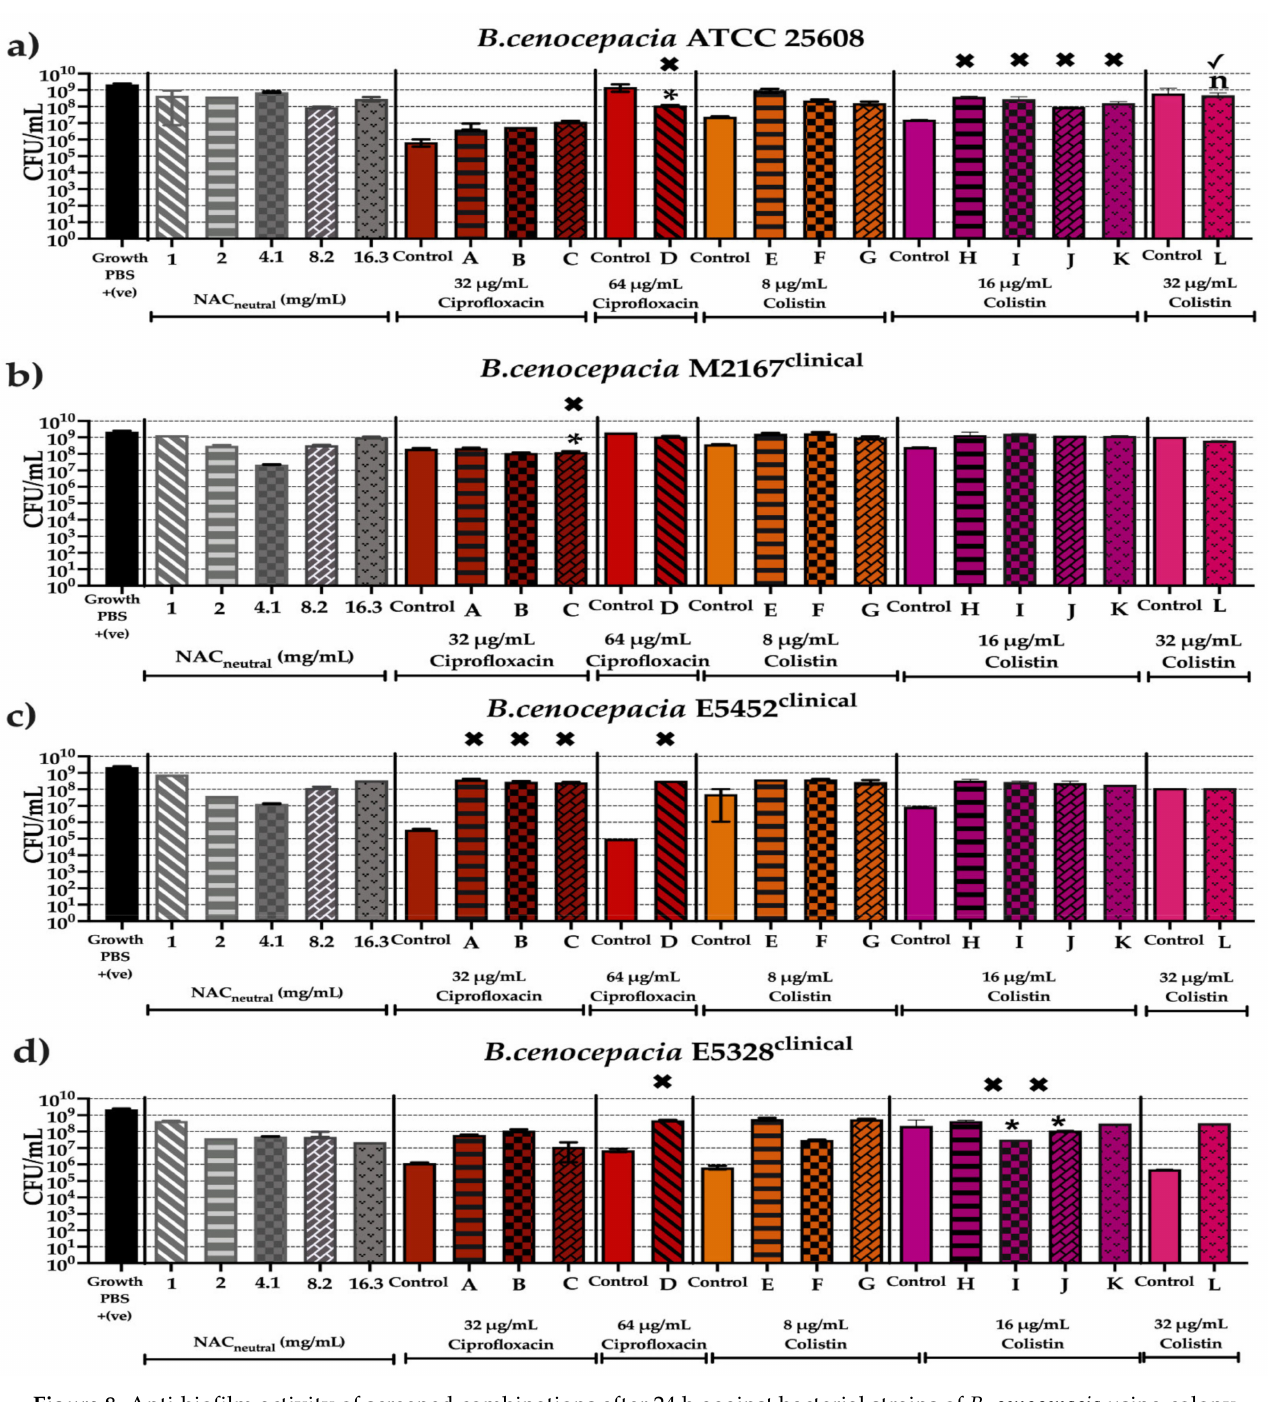
Figure 8. Anti-biofilm activity of screened combinations after 24 h against bacterial strains of B. cenocepacia using colony forming units (CFU/mL). In vitro effectiveness of combination therapies (CT) (Table 3) after 24 h on following B. cenocepacia strains ( a ) ATCC 25608, ( b ) M2167, ( c ) E5452, ( d ) E5328. ( (cid:51) ) represents combination tested does correspond to planktonic result in FICI analysis. ( (cid:54) ) represents combination tested does not correspond to planktonic result in FICI analysis. Statistical analyses were performed using unpaired Student’s t -tests (with Welch’s correction) and multiple comparison tests (Kruskal– Wallis test with Dunn’s correction). Significance cut-offs are as follows p > 0.05 ( n ), p ≤ 0.05 (*). Data represent an average of n = 3 biological